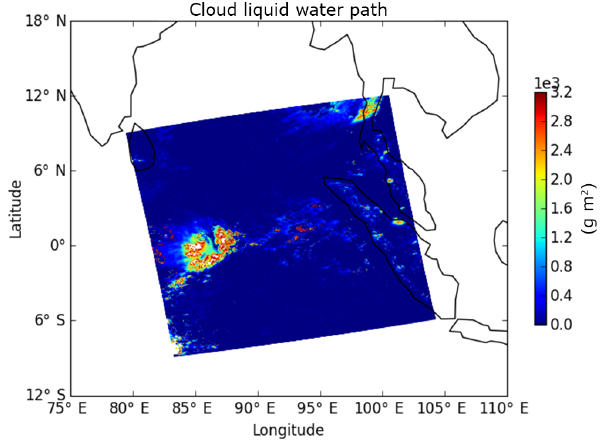
Figure 8. An example plot showing the cloud liquid path over the Indian Ocean just off Malaysia, retrieved by the ESA Cloud CCI product MODIS Aqua (Hollmann et al.,